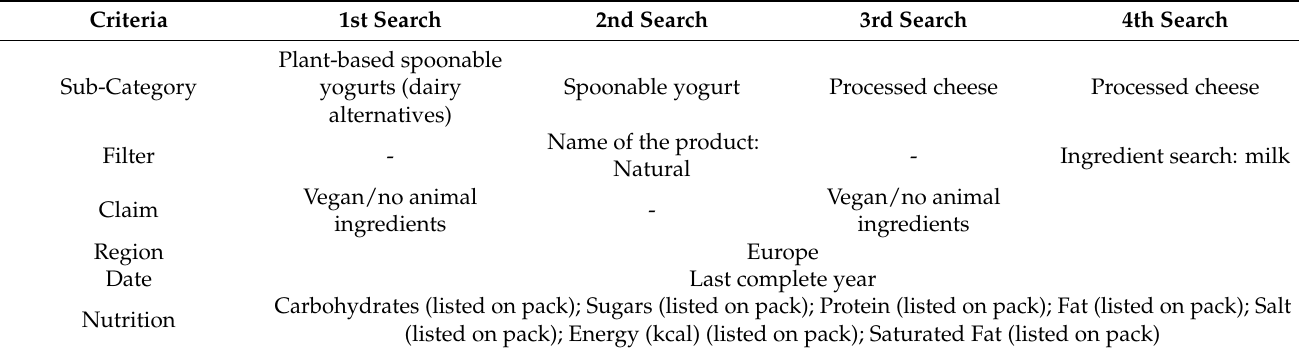
Table 1. Search strategy used on the Mintel Global New Product